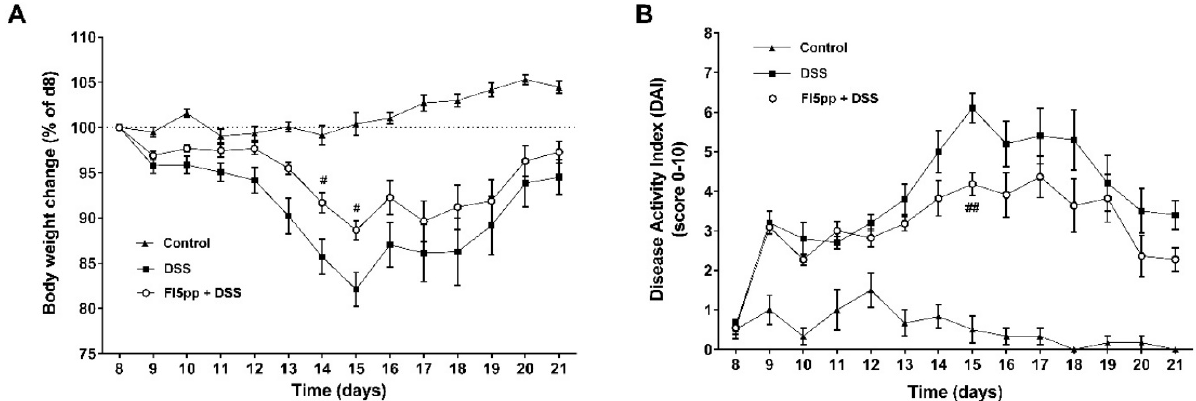
Figure 1. Severity of DSS-induced colitis was determined by proportional body weight change ( A ) and disease activity index (DAI) ( B ). Results are expressed as the mean ± SEM (control n = 6, DSS n = 10, FI5pp+DSS n = 11). Statistical analysis was performed by two-way ANOVA for multiple comparison. #, p < 0.05 and ##, p < 0.01, vs. DSS mice.